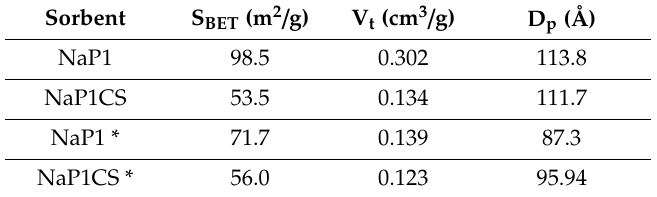
Table 1. Textural parameters of NaP1 and NaP1CS before and after adsorption of Cu(II) and phenol.